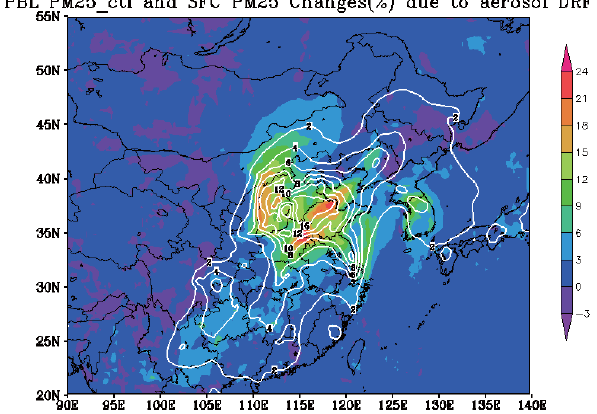
Figure 8. July during the CTL experiment and the surface PM 2 . 5 change percentage due to aerosol DRF for 7–11 July (shaded).